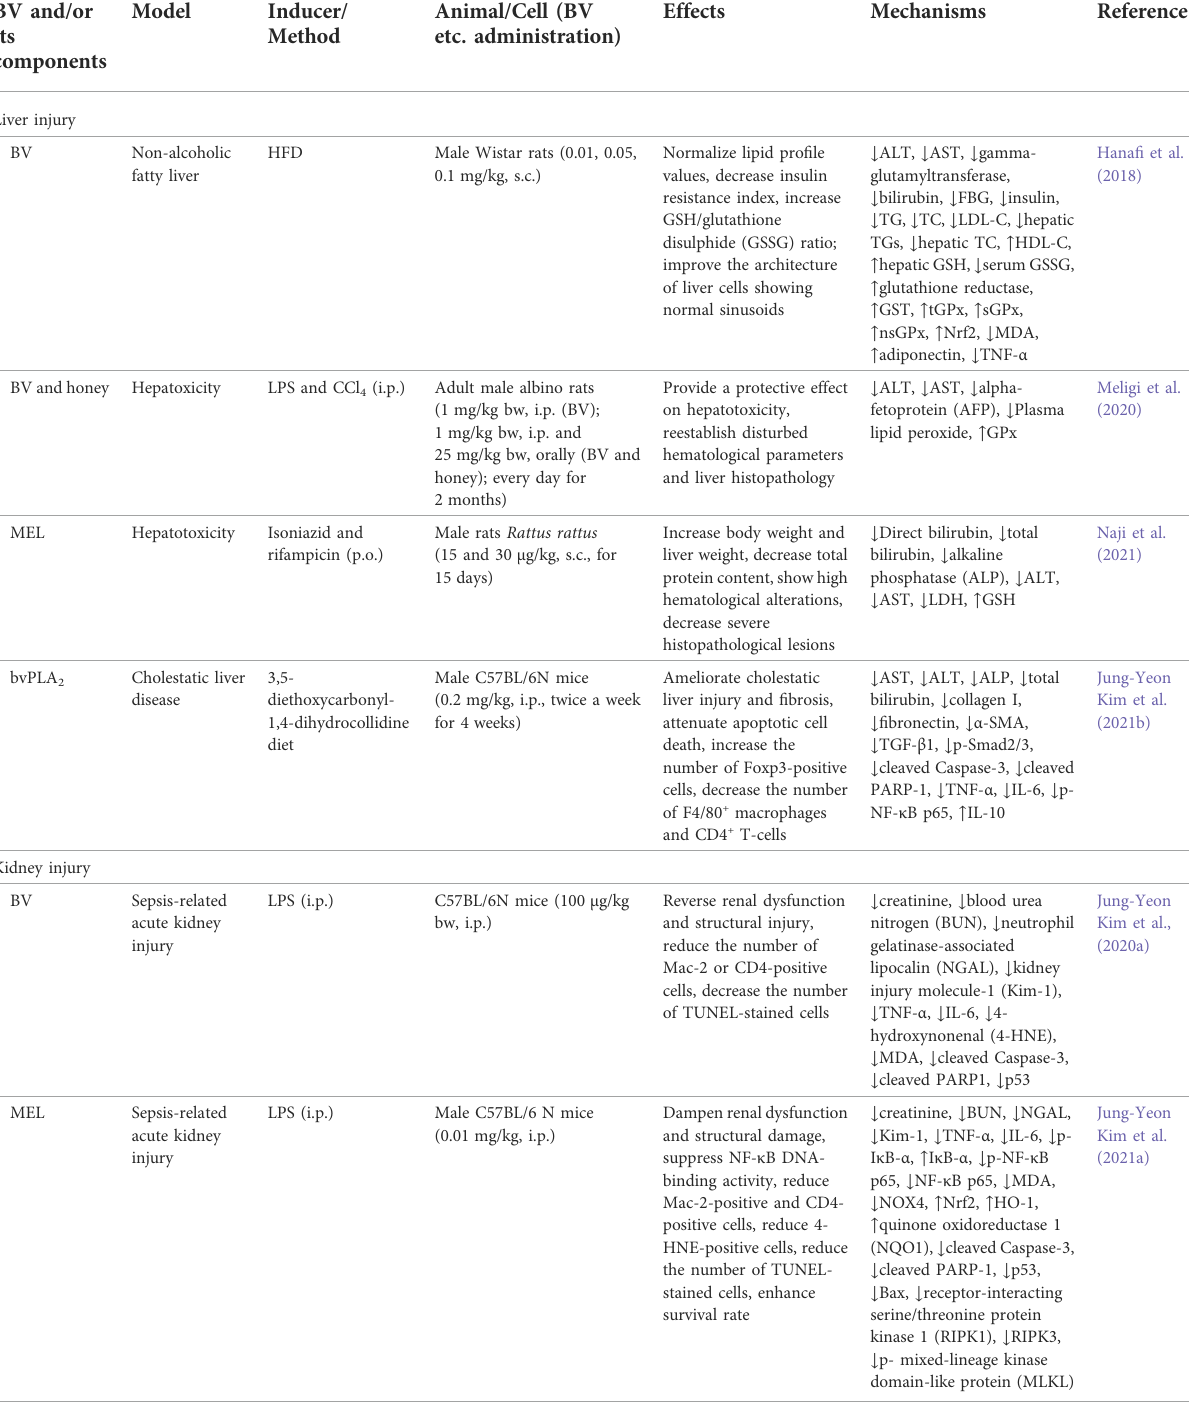
TABLE 6 Summary of the protect effects and mechanisms of BV and its main components on liver, kidney, lung and muscle injury. BV and/or